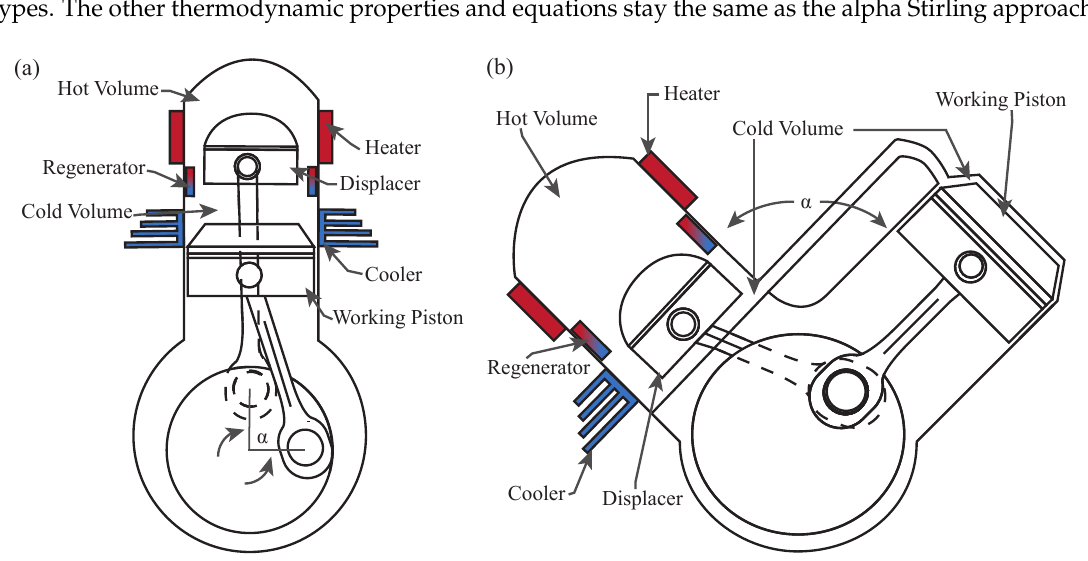
Figure 7. Schematics of ( a ) beta-type and ( b ) gamma-type Stirling